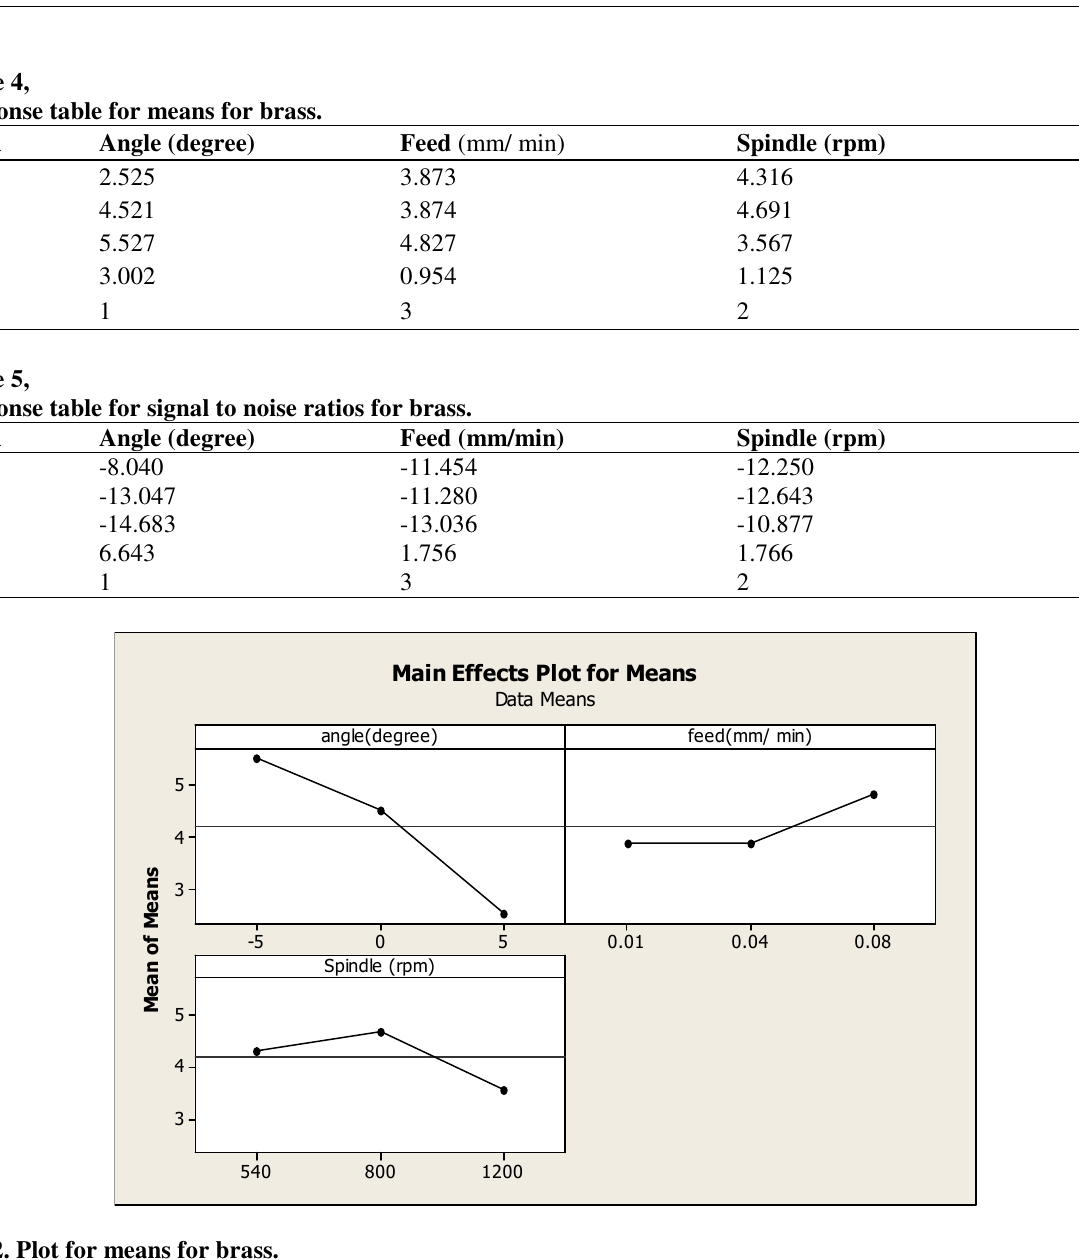
Fig. 2. Plot for means for